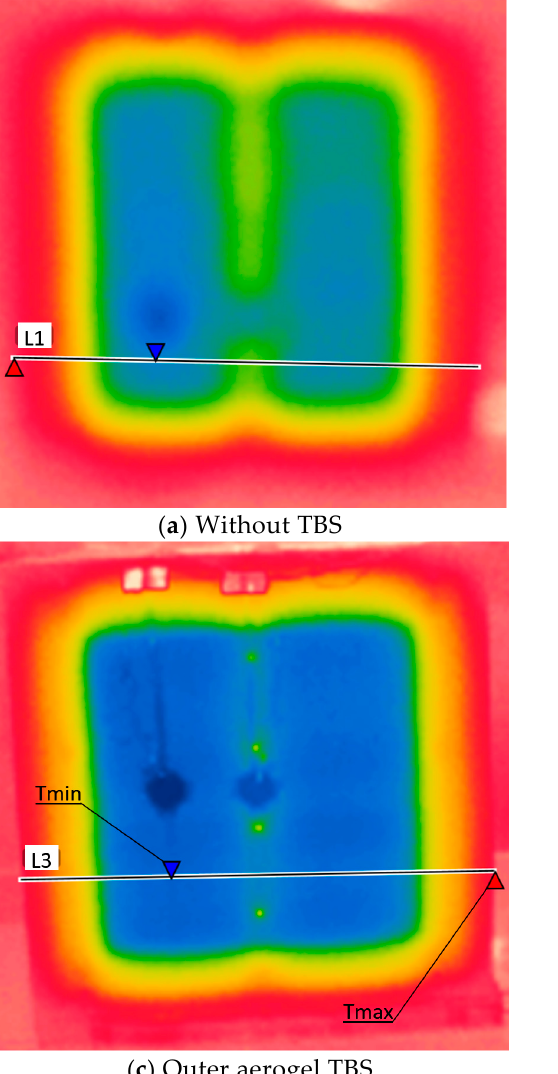
Figure 8. Surface temperatures in the four horizontal lines, L1–L4, previously identified in Figure 7.